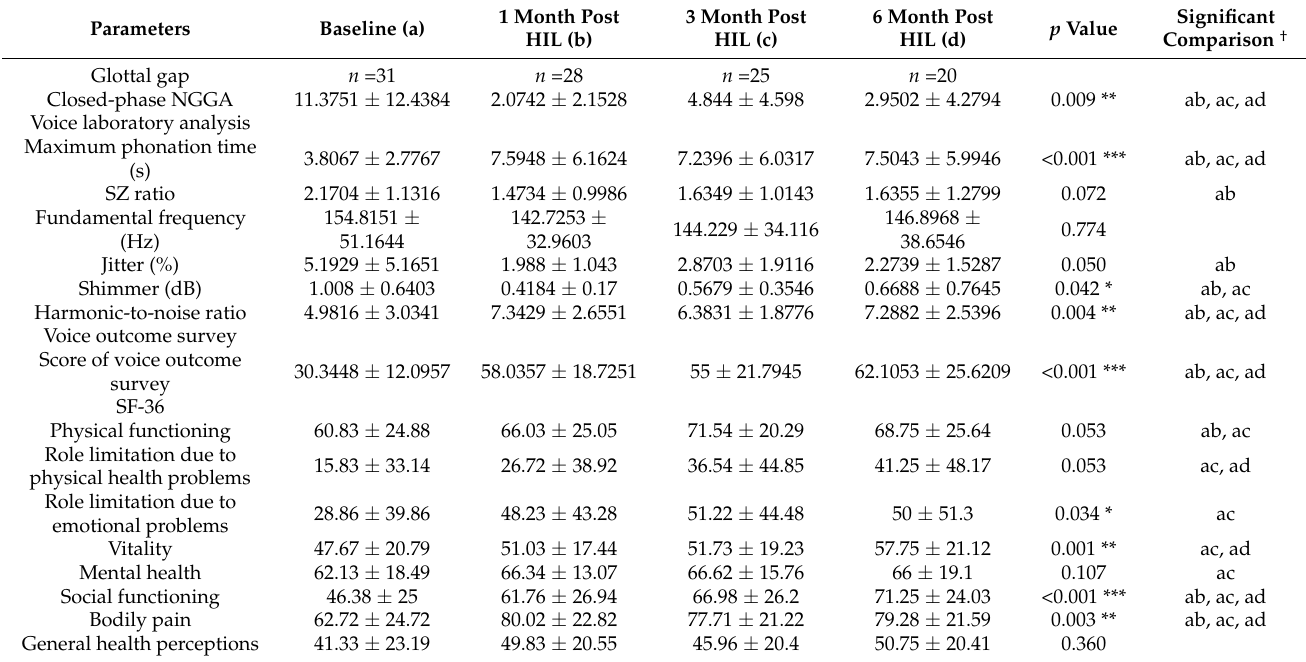
Table 4. The change of parameters in the comprehensive voice assessment after